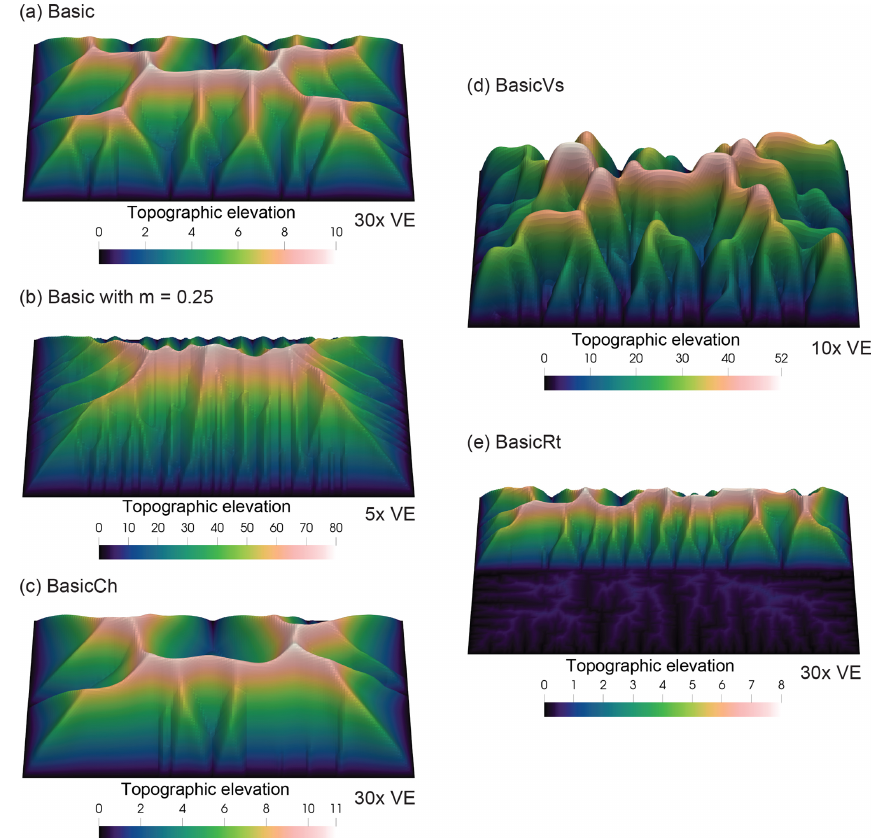
Figure 1. Three-dimensional view of simulated topography illustrating the use of five different terrainbento model programs: (a) Basic, (b) Basic with m = 0 . 25, (c) BasicCh, (d) BasicVs, and (e) BasicRt. Each landscape was initialized with the same random noise field, has the same boundary conditions of the center core nodes uplifted relative to a fixed boundary, and was run to steady state (based on topographic change between 1000-year intervals exceeding 1mm at no grid cell). Each domain is 1 × 1 . 6km, has 10m grid spacing, and is displayed with a vertical exaggeration of 5 to 30 × .